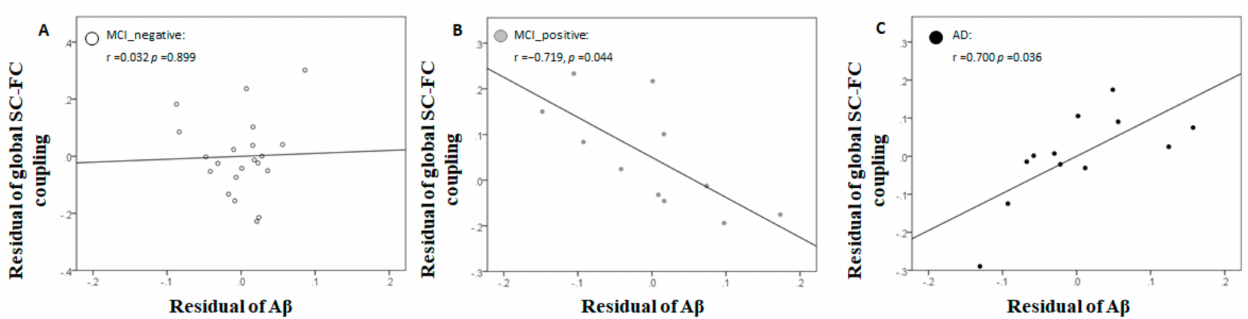
Figure 4. Scatter plots between A β deposition and global SC-FC coupling after controlling for age, sex, and Fazekas score for ( A ) MCI_A β -, ( B ) MCI_A β +, and ( C ) AD patients. Partial Pearson correlation controlling for age, sex, and Fazekas score was